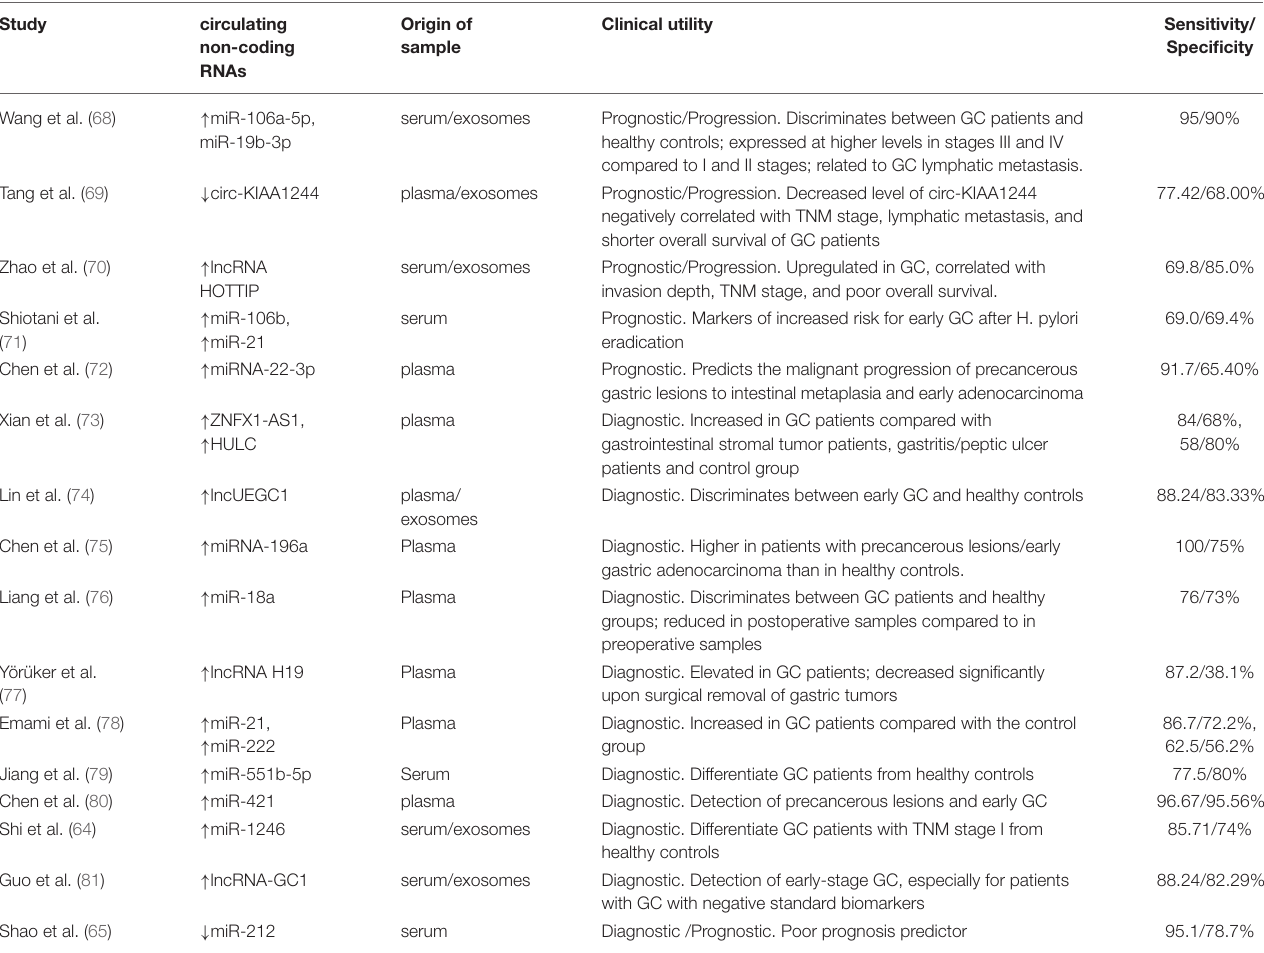
TABLE 3 | Aberrant expression of circulating non-coding RNAs in GC patients.